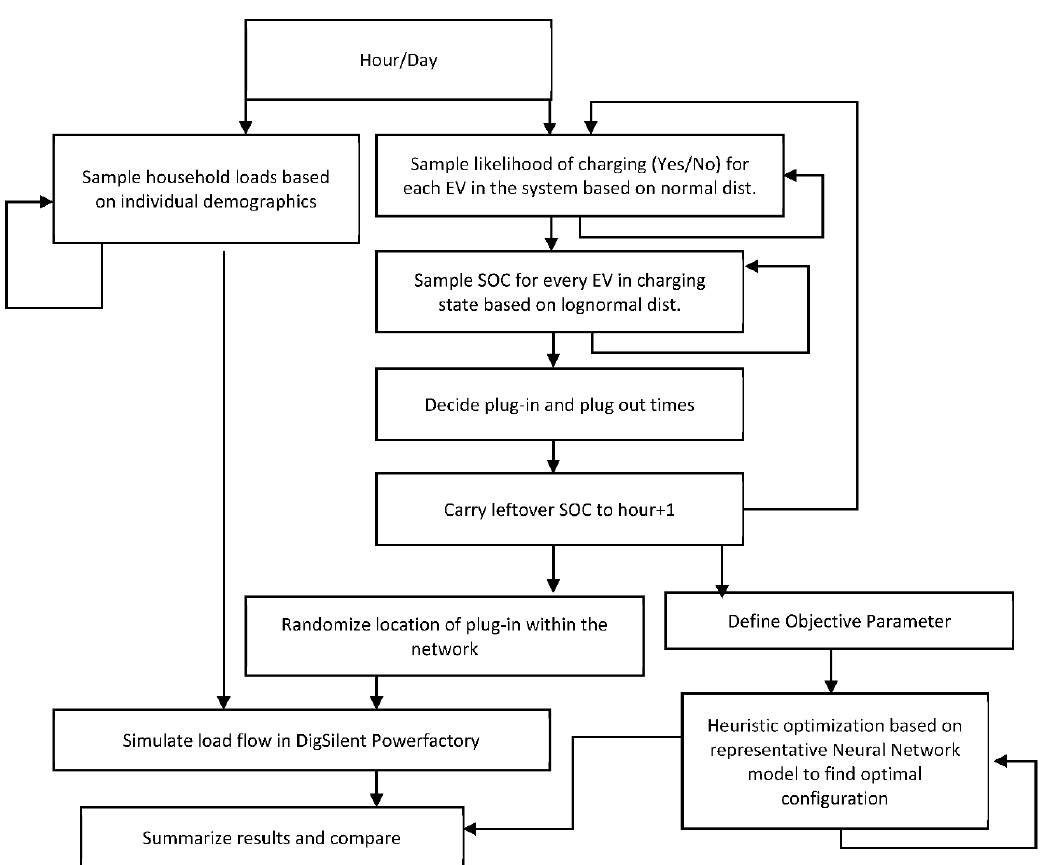
Figure 8. Overall Monte Carlo simulation methodology. For each hour, the simulation is repeated 10 7 times to achieve a representative normal distribution.